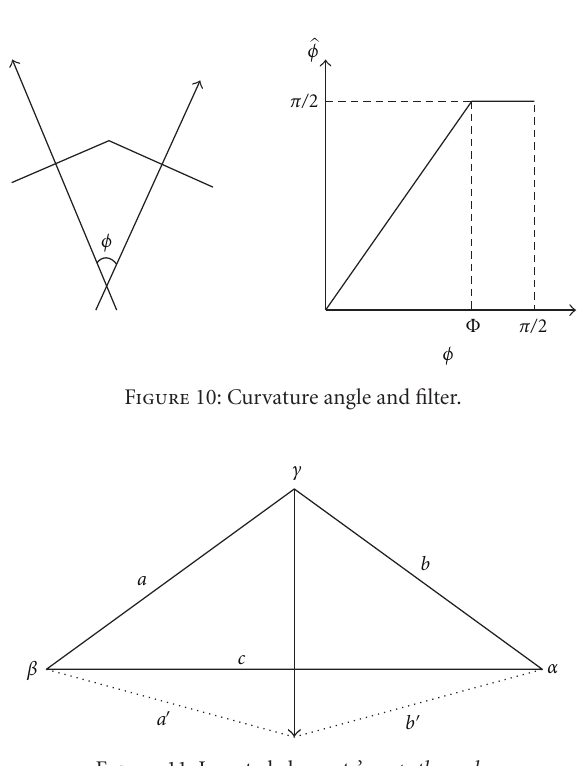
Figure 11: Inverted elements’ snap-through .